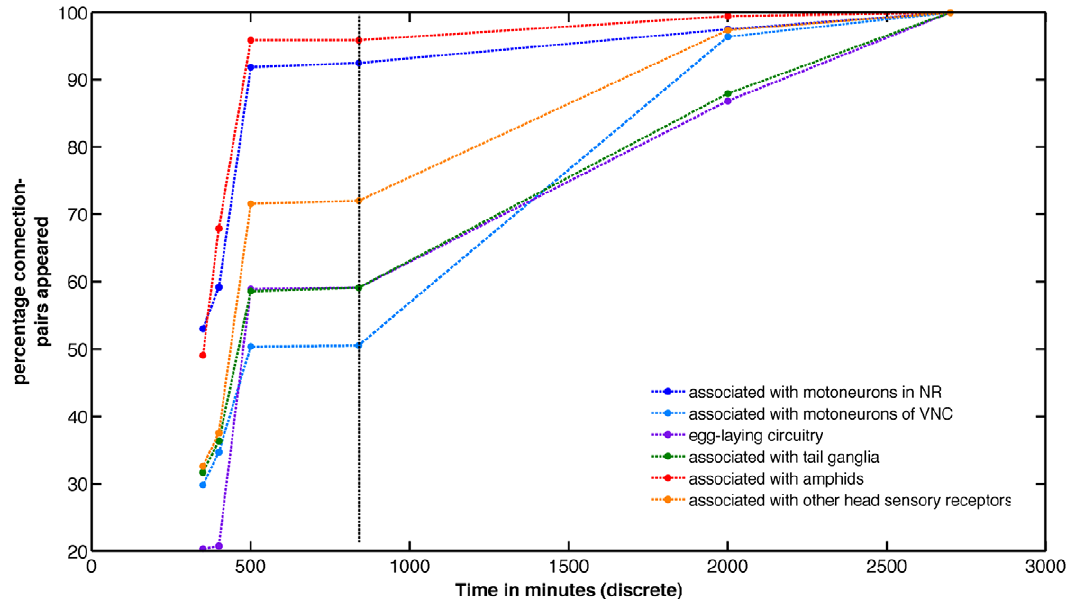
Figure 6. The progressive appearance of ‘connection-pairs’ belonging to the various circuits during development. Time along x-axis is represented in discrete time steps. The circuits associated with sensory feedback and survival appear sooner. Note that appearance is with respect to both neurons that are connected in the adult being born at that time, actual synaptogenesis may occur at a later time. The dashed line represents the time of hatching. (NR – Nerve Ring and VNC – Ventral Nerve Cord)